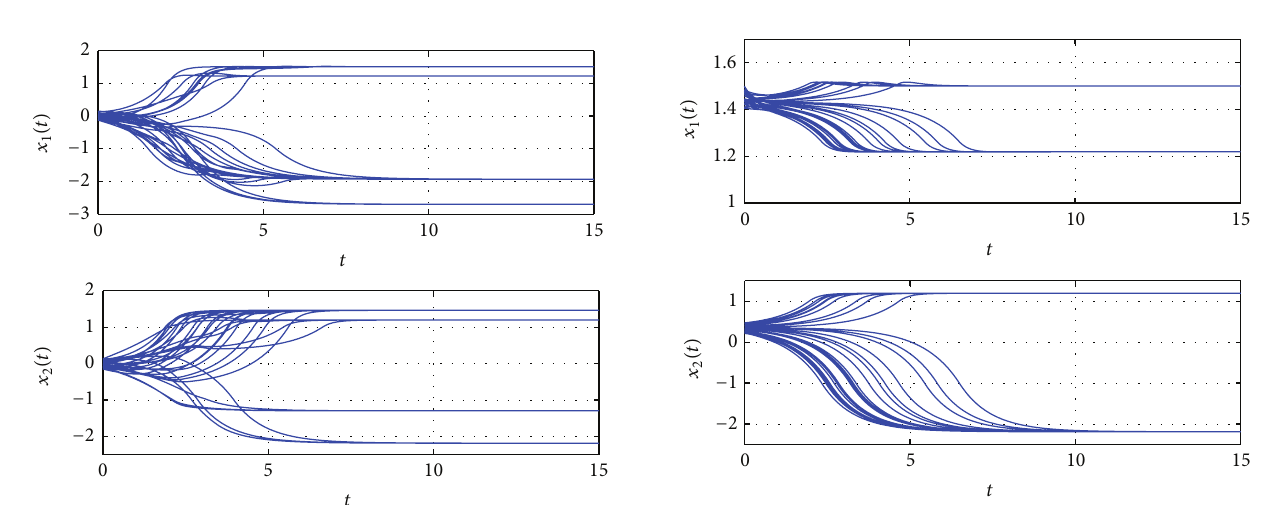
Figure 11: Transient behavior of 𝑥 1 and 𝑥 2 near the equilibrium point (402/281, 100/281, 80/281, 50/281) 𝑇 in Example 1.